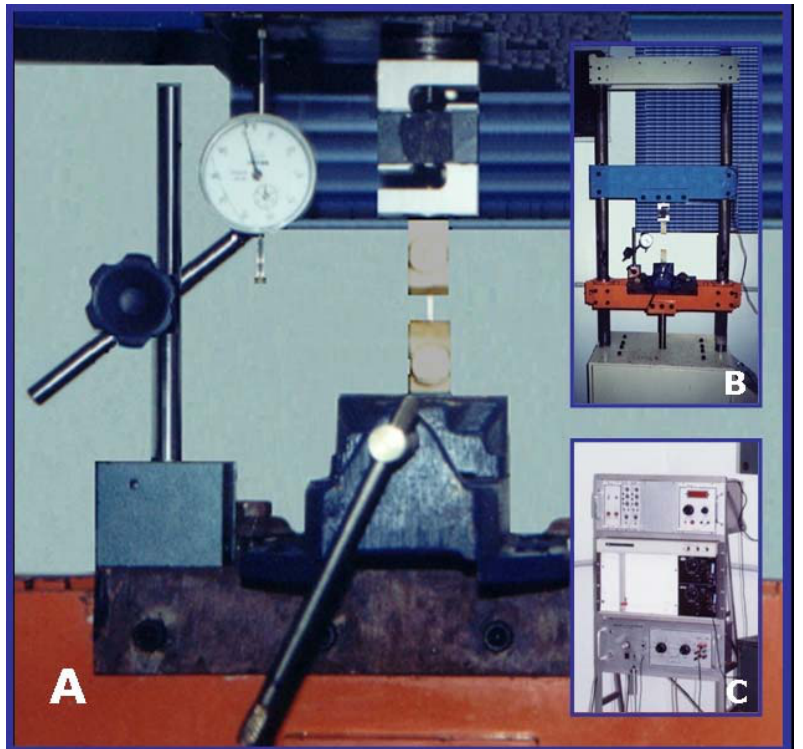
Figure 1: Dog tendon segment during the mechanical traction assay. Details of the jaws and the dial micrometer (A); Universal Test Machine overall view (B); extensometry bridge